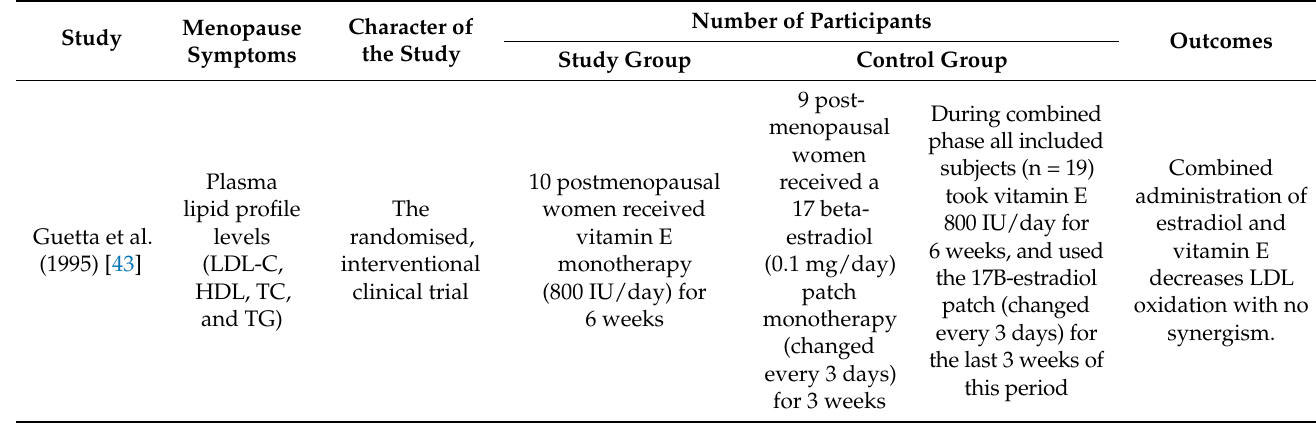
Table 4. Characteristics of included studies concerning lipid profile and vascular